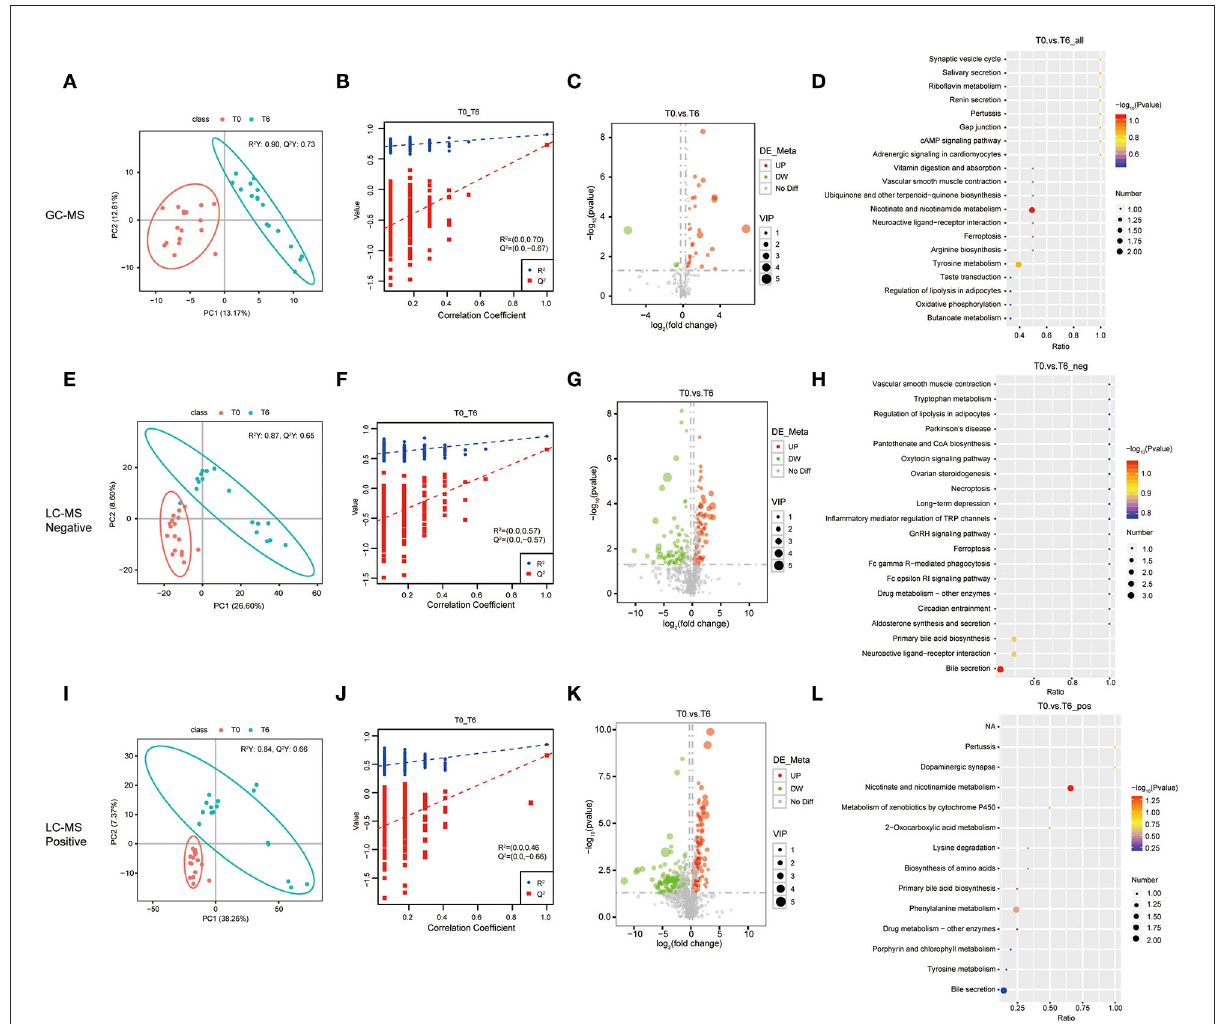
FIGURE2 Identification of serum metabolites between the cured PTB group (T6) and the untreated PTB group (T0). The PLS-DA model for the T0/T6 group in GC-MS (A) , LC-MS/MS (–) (E) , and LC-MS/MS ( + ) (I) . The permutation test results for theT0/T6 group in GC-MS (B) , LC-MS/MS (–) (F) , and LC-MS/MS ( + ) (J) . Volcanic map of differential metabolites for the LT/Un group in GC-MS (C) , LC-MS/MS (–) (G) , and LC-MS/MS ( + ) (K) . The abscissa: the fold change of LT/Un group (base 2 logarithm). The ordinate: P -value of T0/T6 group (base 10 logarithm). Red: significantly upregulated metabolites. Green: significantly downregulated metabolites. Gray: non-significant differential metabolites. Pathway analysis of differential metabolites for the T0/T6 group in GC-MS (D) , LC-MS/MS (–) (H) , and LC-MS/MS ( + ) (L)